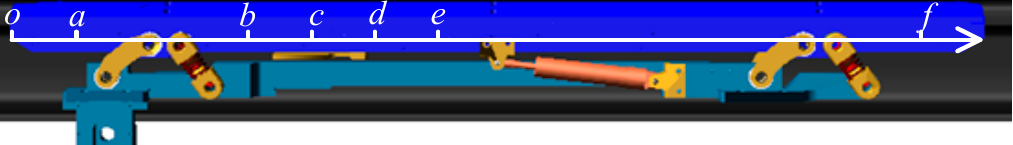
Figure 8. The schematic diagram of different measuring positions at the measuring ruler.